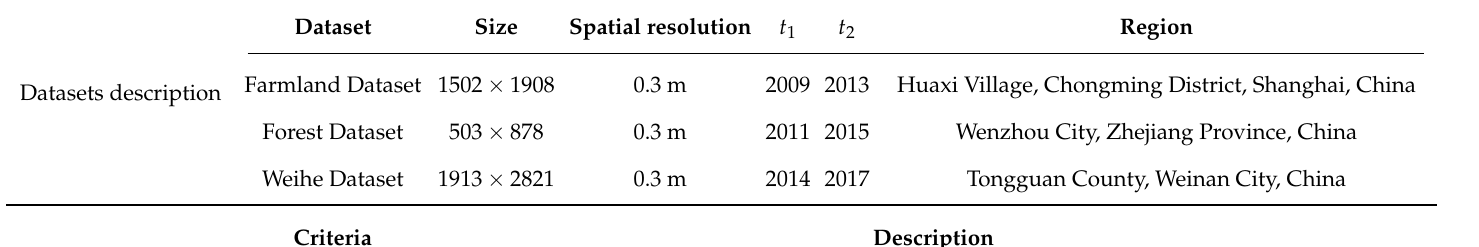
Table 1. Brief summary of datasets, criteria and comparison